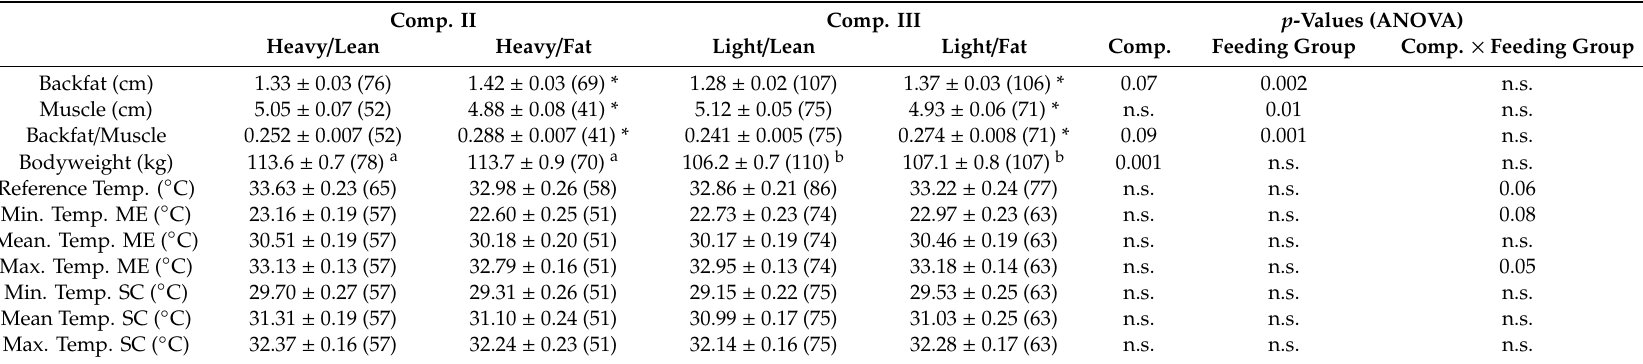
Table 6. Body condition values and body surface temperatures (mean ± SE ( n )) for compartment II and III on measurement day 3, according to the feeding groups. Comp. II Comp. III p -Values (ANOVA) Heavy / Lean Heavy / Fat Light / Lean Light / Fat Comp. Feeding Group Comp. × Feeding